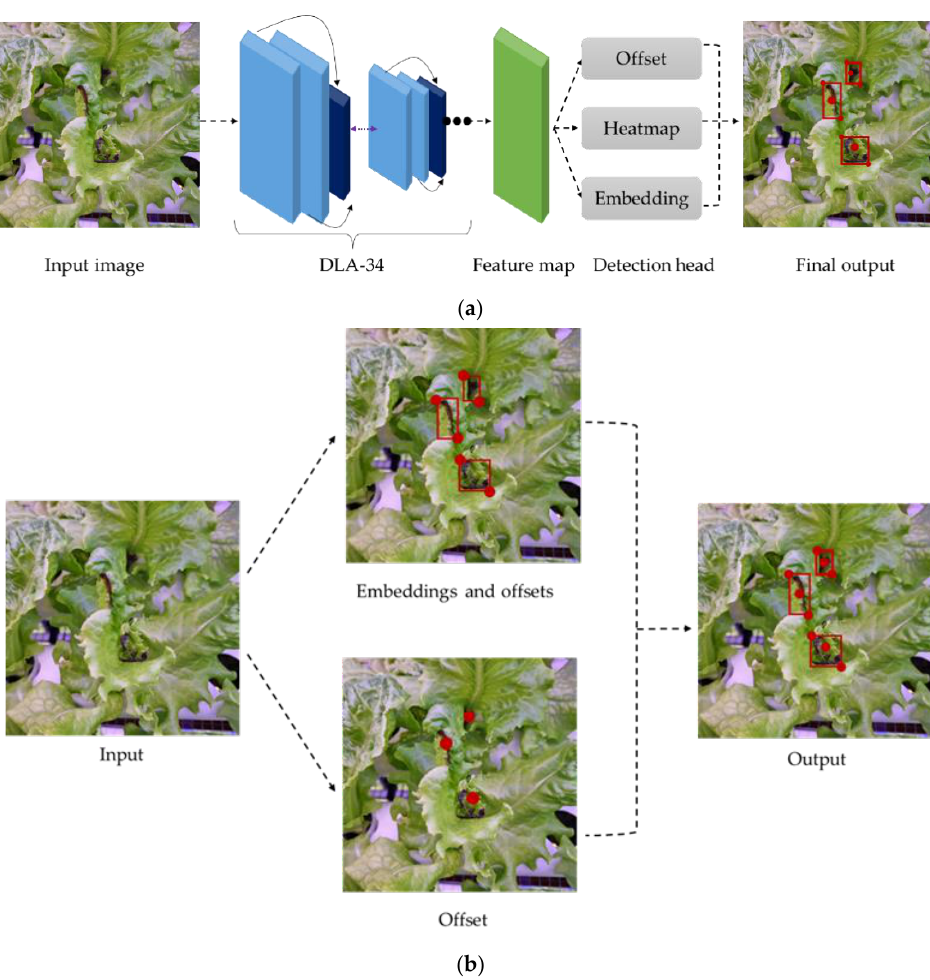
Figure 3. Working principle of CenterNet model ( a ) detection process of CenterNet based on back- bone DLA-34; ( b ) tip-burn detection based on triplet key points. DLA-34; ( b ) tip-burn detection based on triplet key